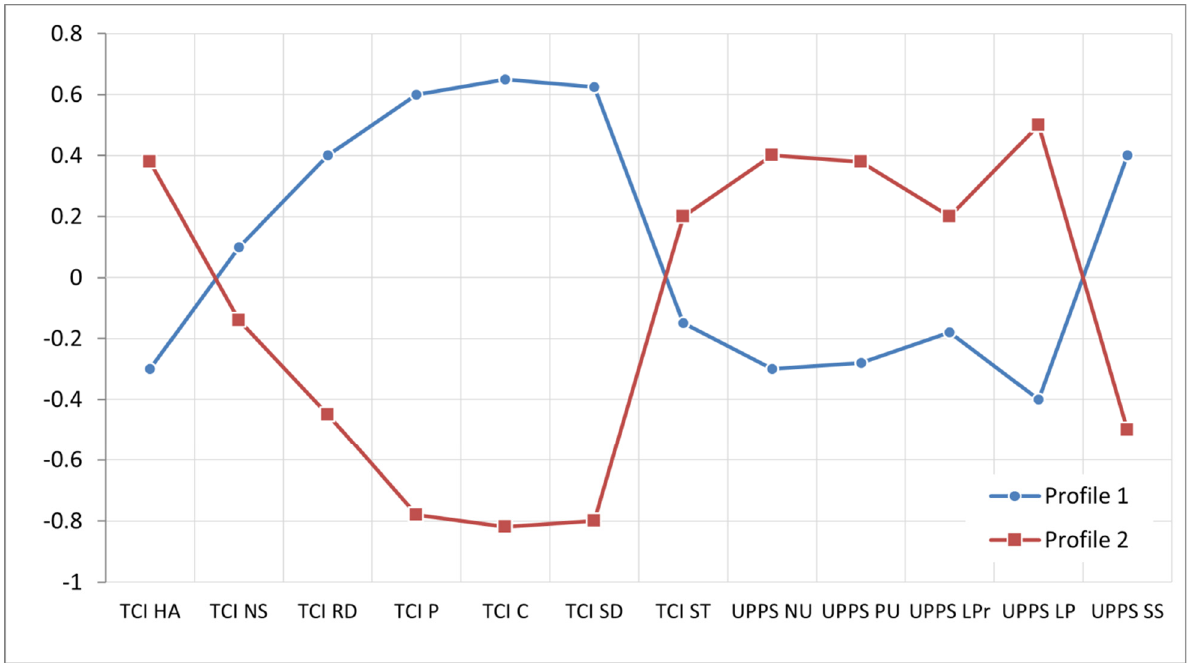
Figure 2. The temperament, character and impulsiveness profiles of short track athletes. Table 3. Statistical measures of temperamental, character and impulsiveness profiles. Statistical Significance of Differences between Means